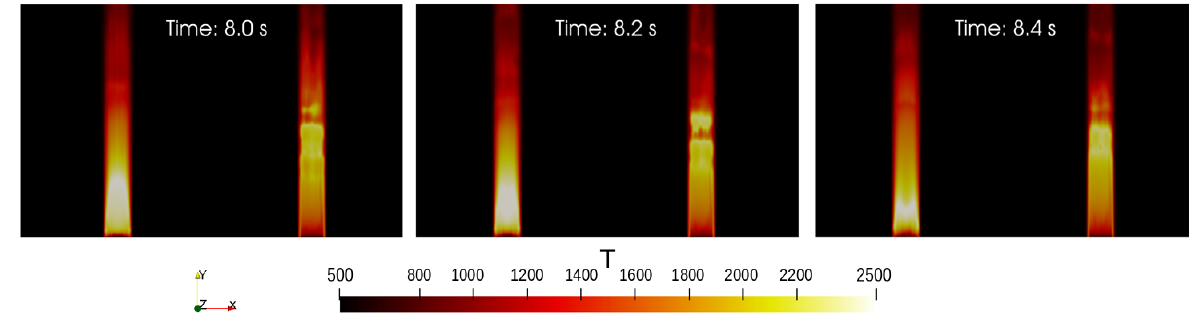
Figure 5. Temperature description in the domain. Three different time steps are considered. The figures show on the left the flame generated by the hydrogen combustion and on the right the one generated by the methane combustion. The two flames are different from each other. They differ both in terms of temperature and in terms of size.